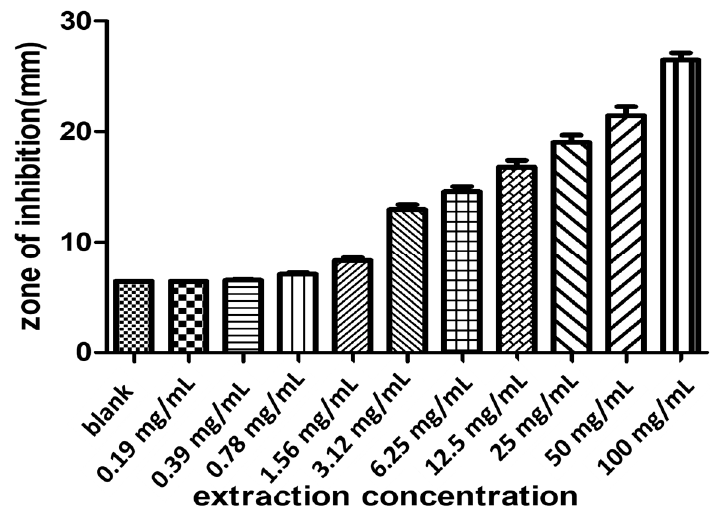
Figure 5. Comparison of the ZOI of the treatments of extract of Oak fruit.